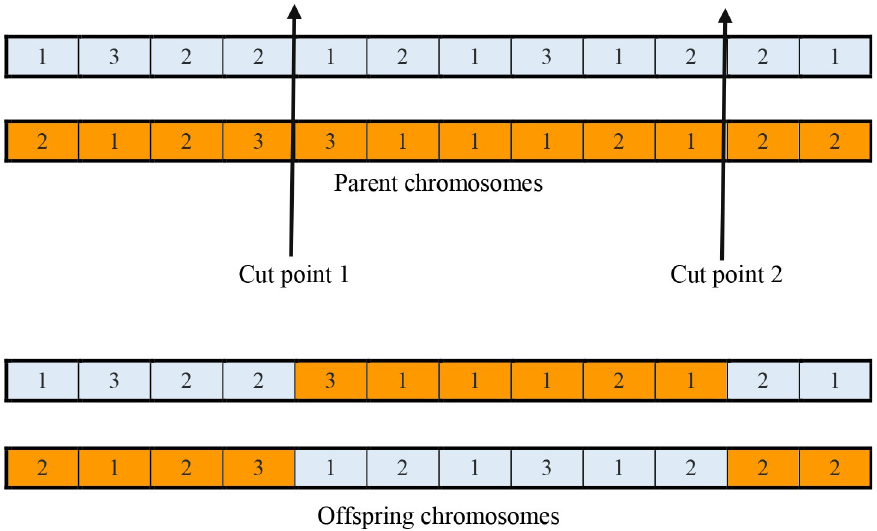
Fig 5. Example of two-point crossover with label-based solution representation for a clustering solution using of twelve data.